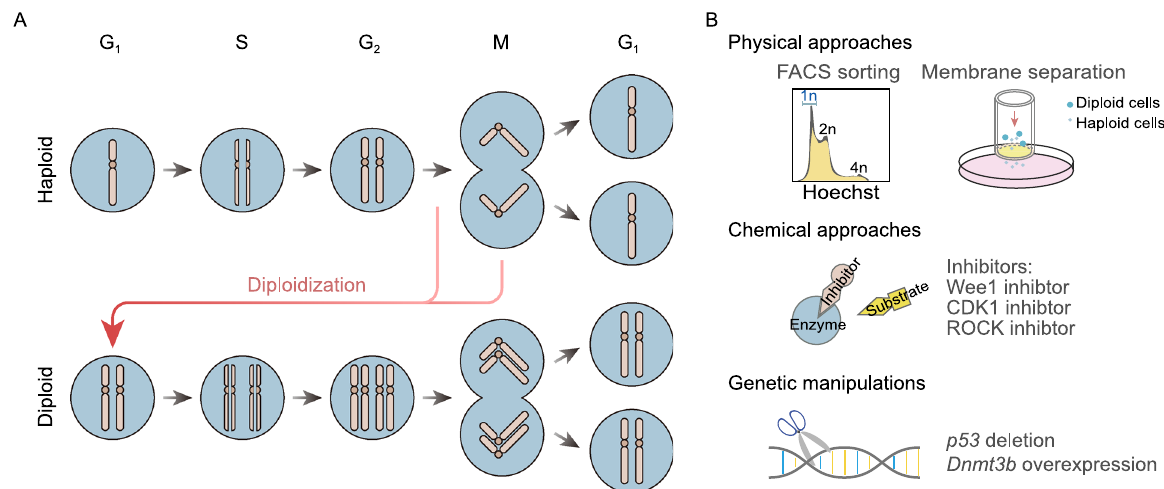
Figure 2. Diploidization of haploid cells. (A) Schematic showing that abnormal cell cycle regulation is the cause for diploidization in haploid cells. (B) Solutions for diploidization include physical approaches using fl uorescence-activated cell sorting (FACS) and membranes with micrometer pores, chemical approaches via addition of kinase inhibitors and genetic manipulations in